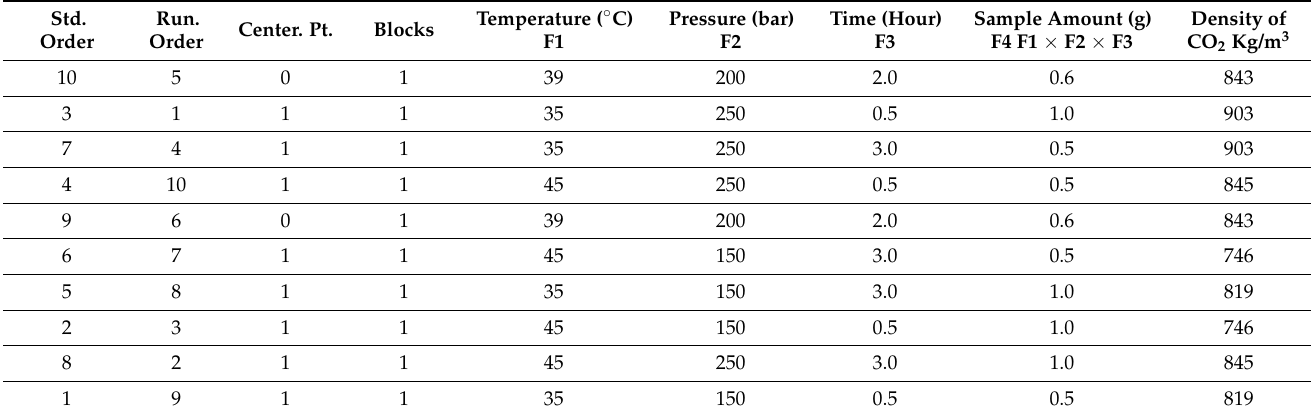
Table 2. Experimental matrix for the 2 4 − 1 design for the extraction.